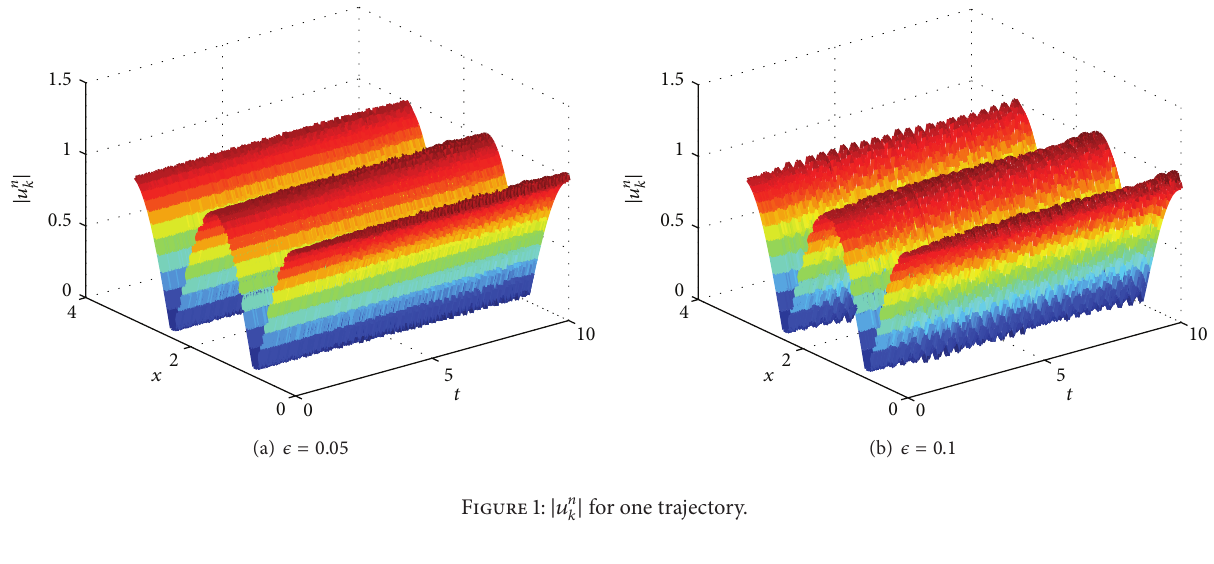
Figure 1: |𝑢 𝑛 𝑘 | for one trajectory.